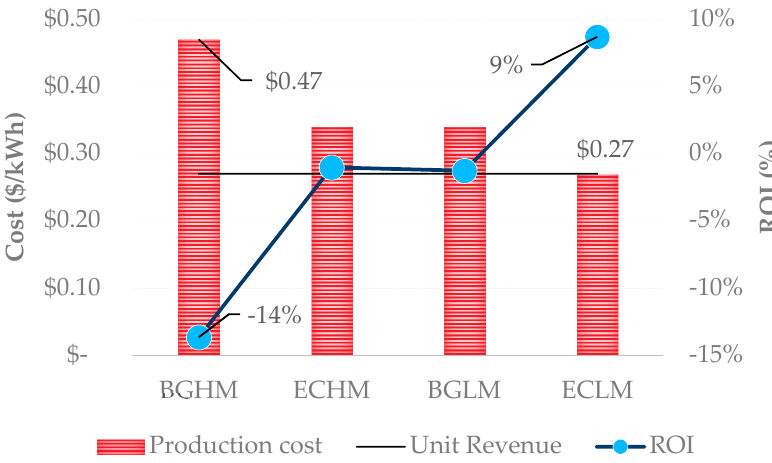
Figure 6. Profitability indexes including production cost ($/kWh), unit revenue ($/kWh) and return on investment (%) for the four different scenarios exploited in this study.